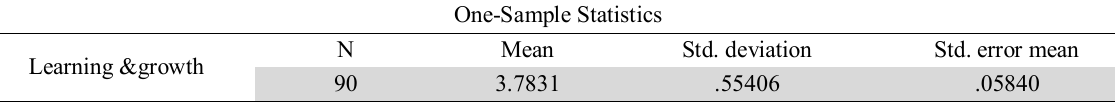
Results of descriptive statistics related to the learning & growth